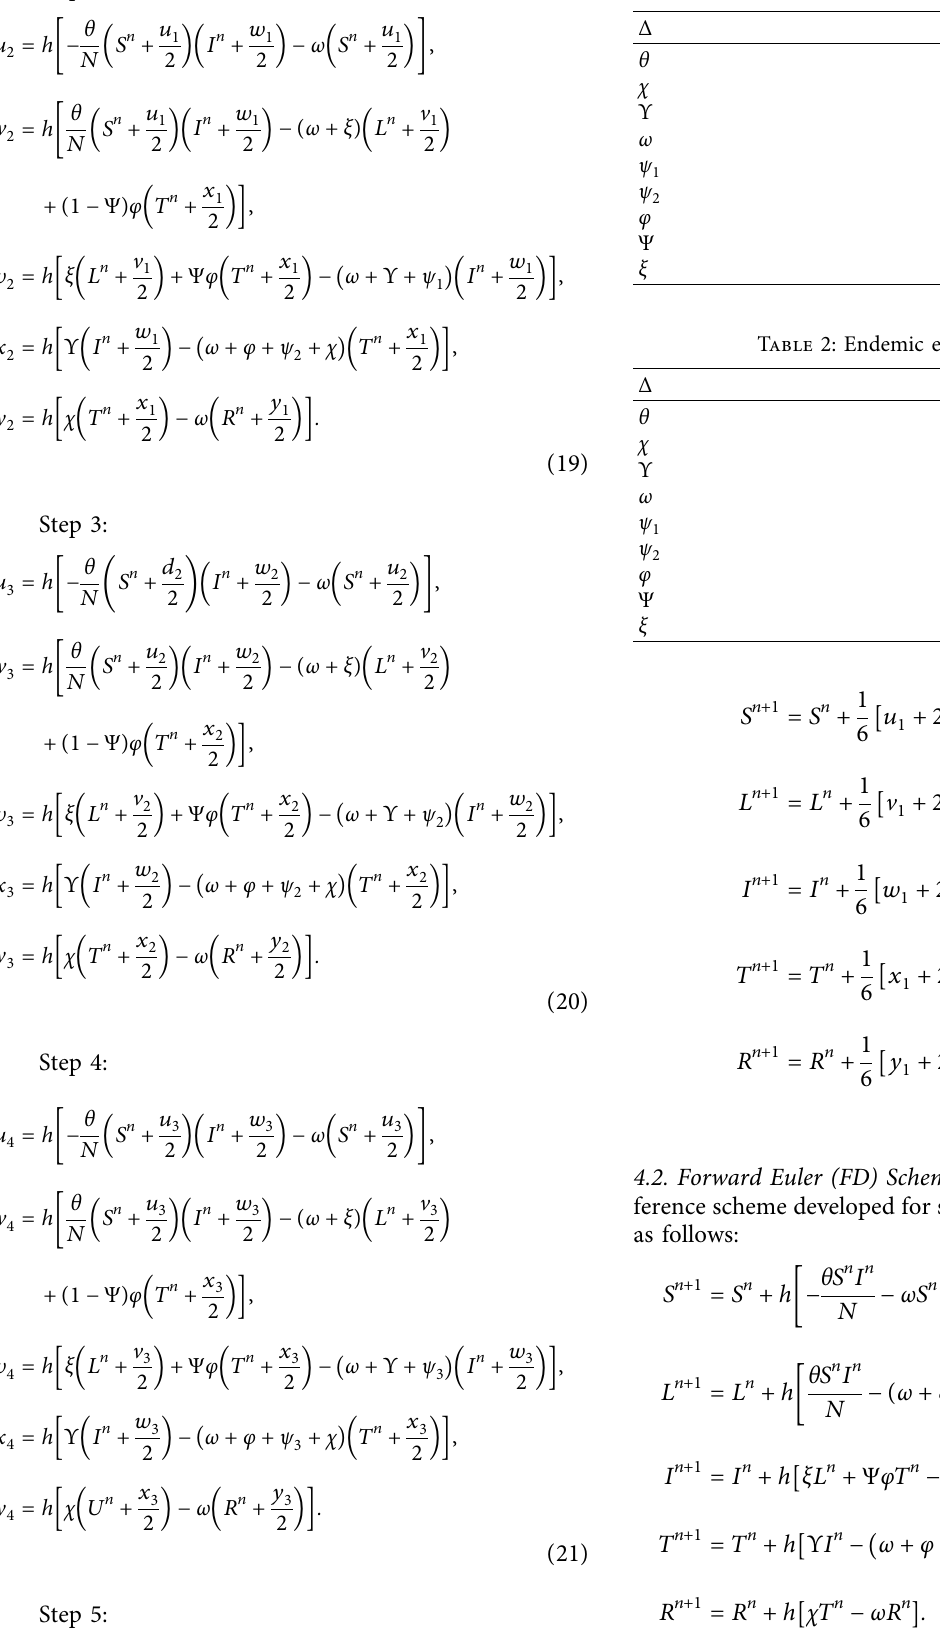
Table 1: Disease-free equilibrium, R